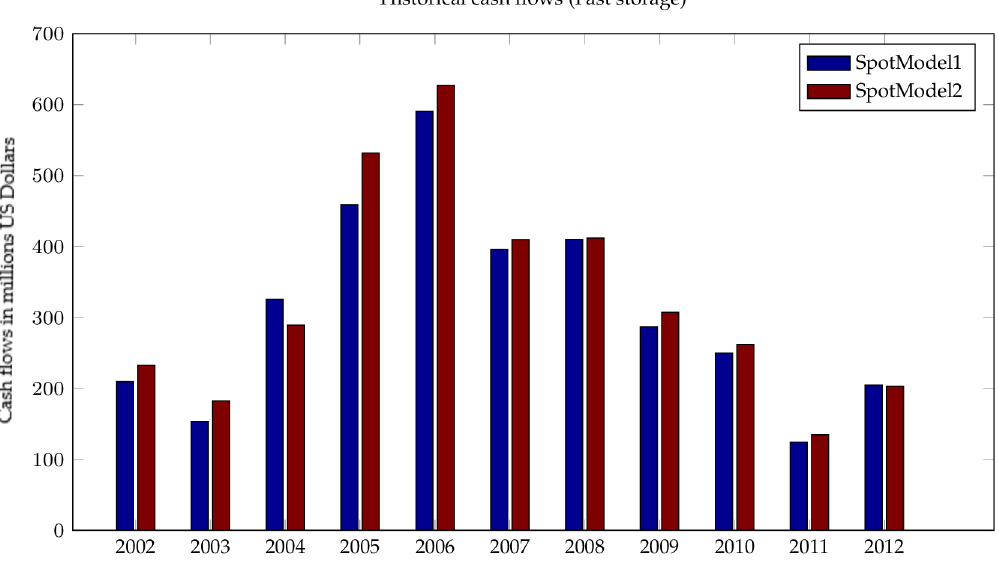
Figure 8. Historical cash flows for spot models 1 and 2 (fast storage).